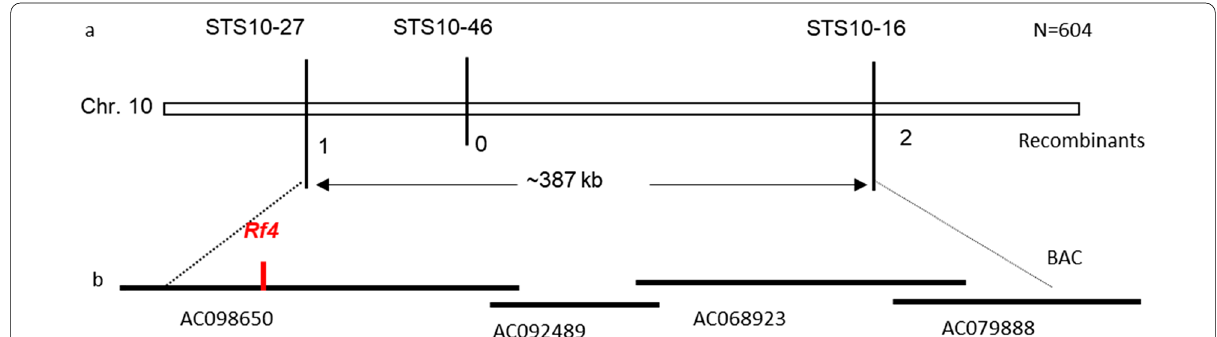
Fig. 2 Genetic mapping of the Rf gene. a Rf gene was mapped into ~ 387 kb physical region flanked by marker STS10-27 and STS10-16 on chromosome 10 that overlapped by AC068950, AC092489, AC068923 and AC079888 ( b